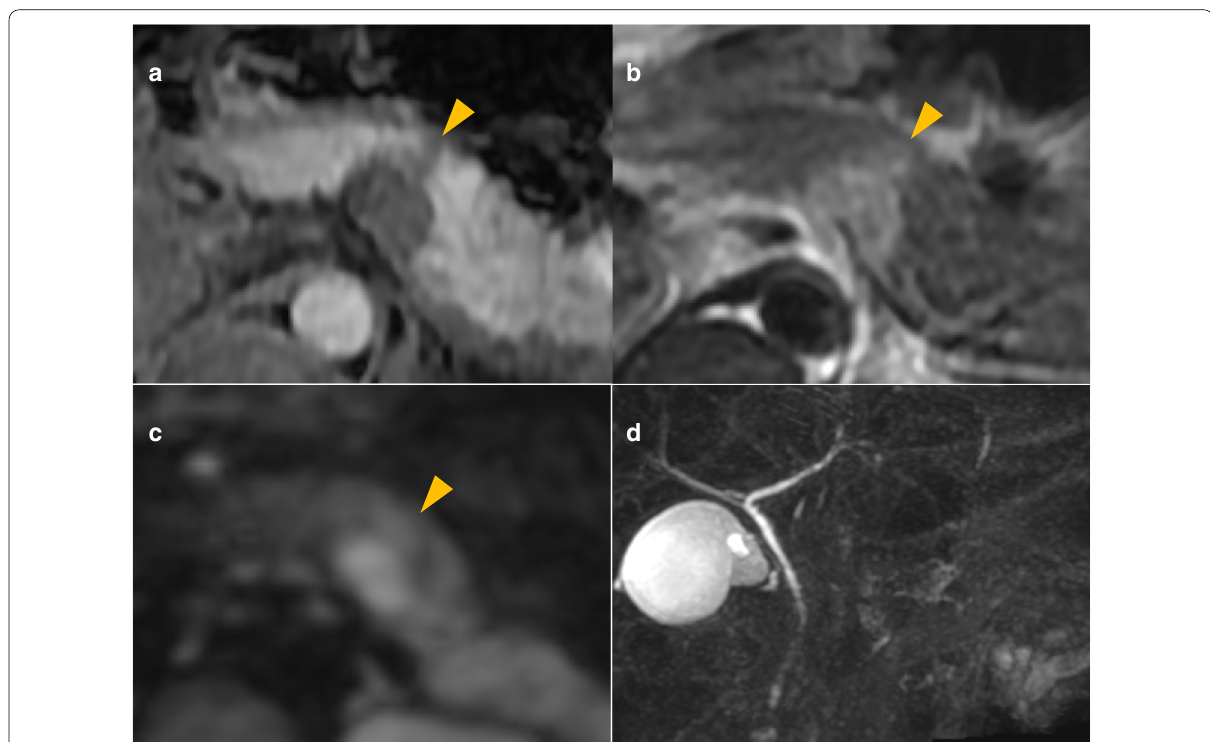
Fig. 2 Magnetic resonance imaging revealed a mass (triangles) exhibiting hypointensity on T1-weighted images ( a ), hyperintensity on T2-weighted images b and diffusion-weighted images c at the pancreas body and tail. Magnetic resonance cholangiopancreatography showed no dilation of the pancreatic duct ( d )